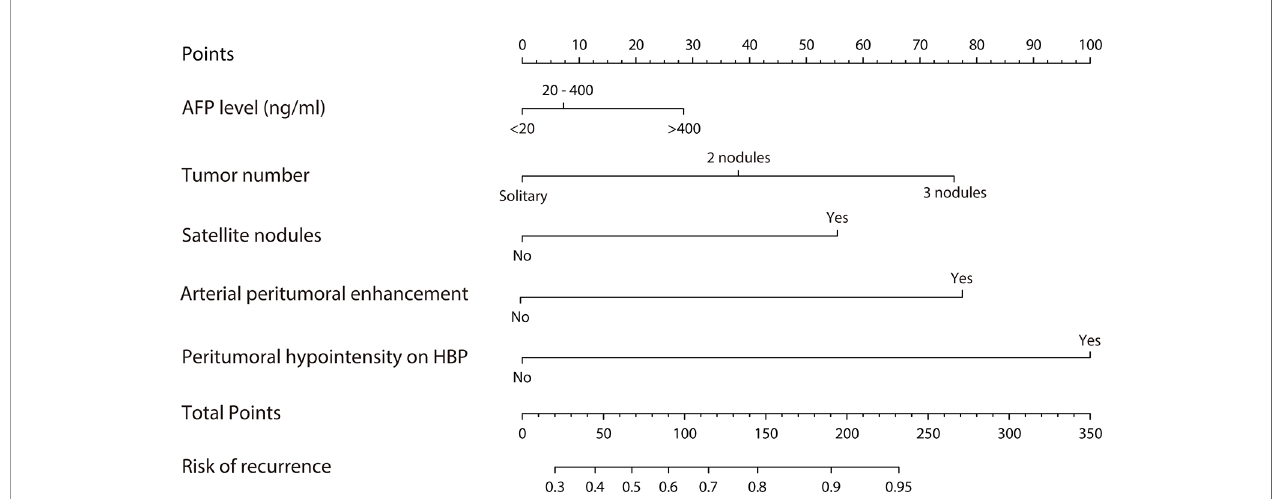
FIGURE 4 | Nomogram predicting probability of early recurrence within 2 years after ablation therapy of